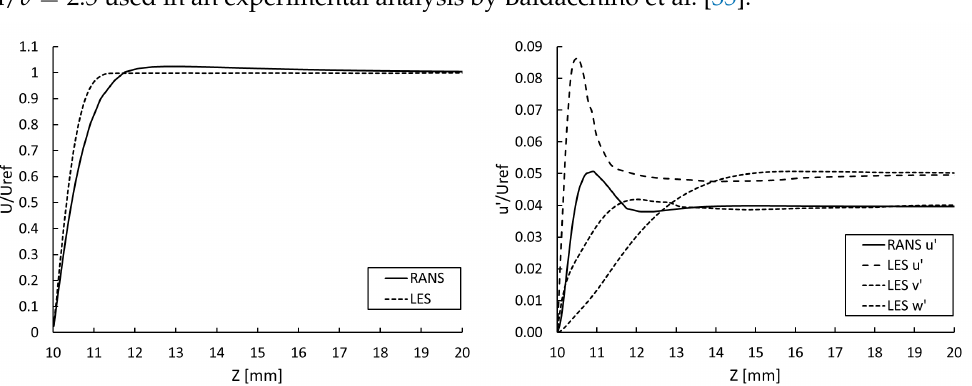
Figure 6. Boundary layer profile in comparison with LES data [34] for an upstream turbulence inten- sity of 5%. Left : normalized axial velocity, right : normalized root-mean-square velocity